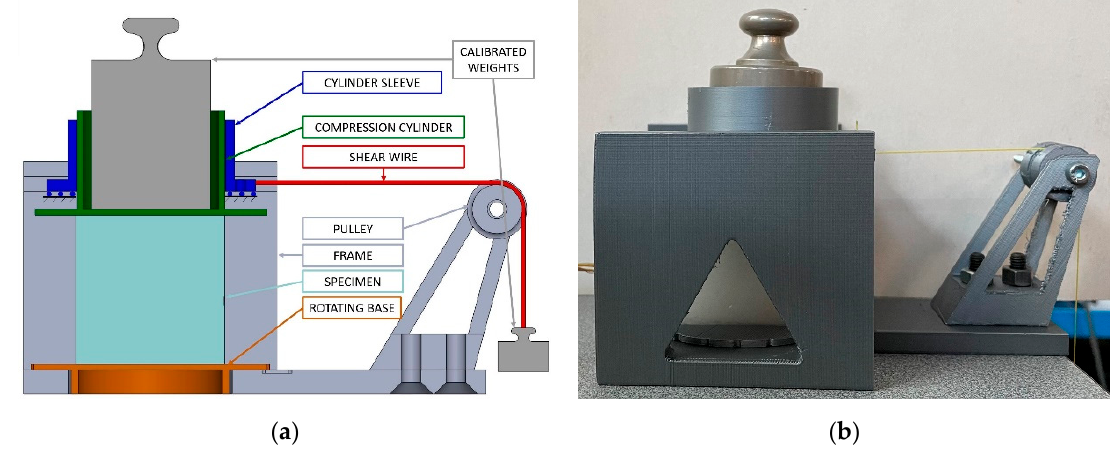
Figure 8. Test bench for the multi-axial evaluation of the sensor: ( a ) Sketch with indication of the components. ( b ) Actual test bench during a compression and shear test.